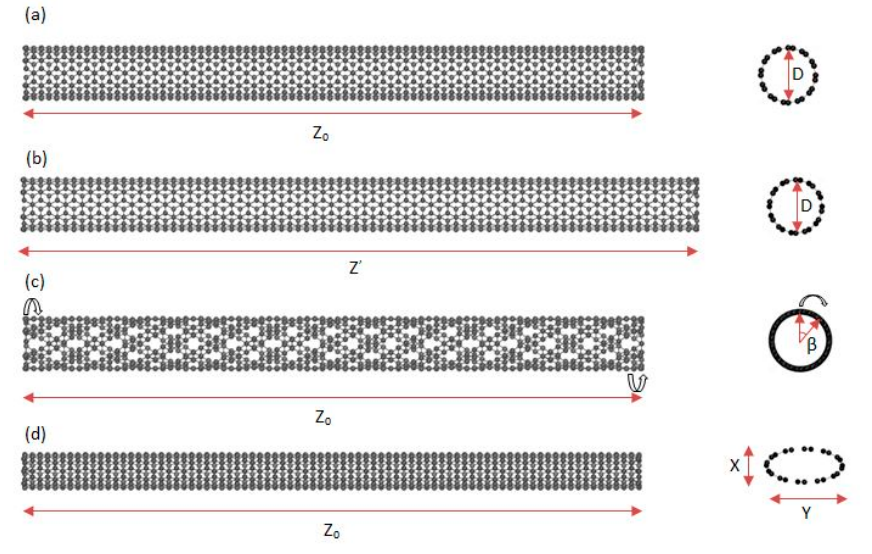
Figure 2. Perfect nanotube and different types of deformed nanotubes: ( a ) perfect nanotube; ( b ) Z-distortion nanotube (stretch factor: Z’ / Z 0 ); ( c ) twisted nanotube (screw factor: β / Z 0 ); and ( d ) XY-distortion nanotube (ellipse factor: e = ∆ X / ∆ Y).